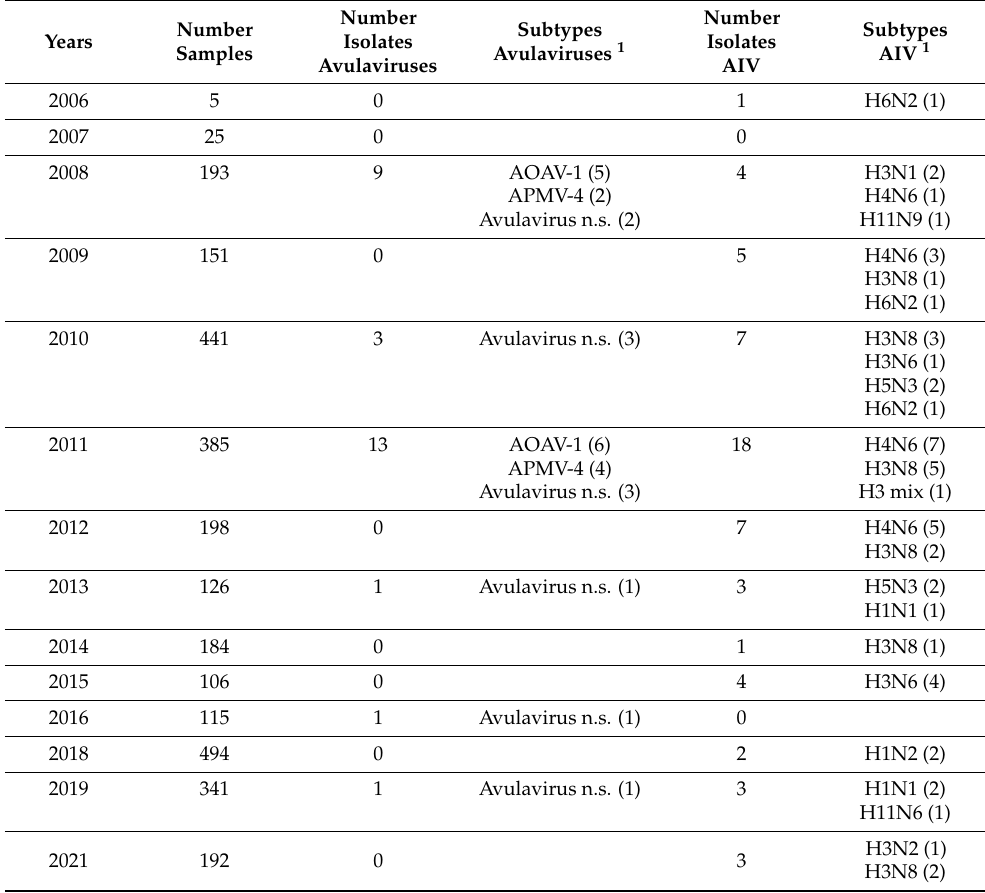
Table 1. Isolation of avulaviruses and influenza A viruses from bird feces collected from the ponds in the Moscow